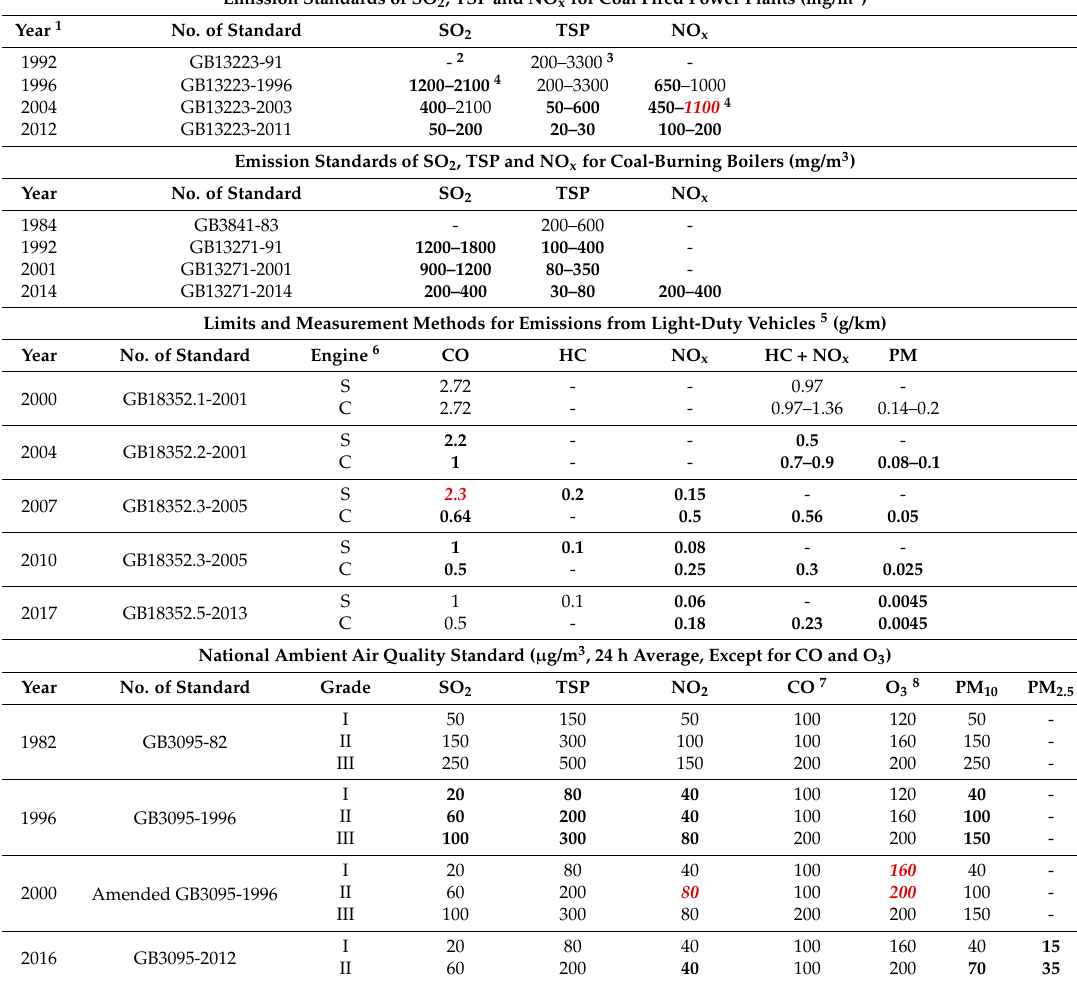
Table 1. Examples of emission standards and air quality standards in China (1980s-current), summarized based on standards available at Ministry of Environment (MEP) website